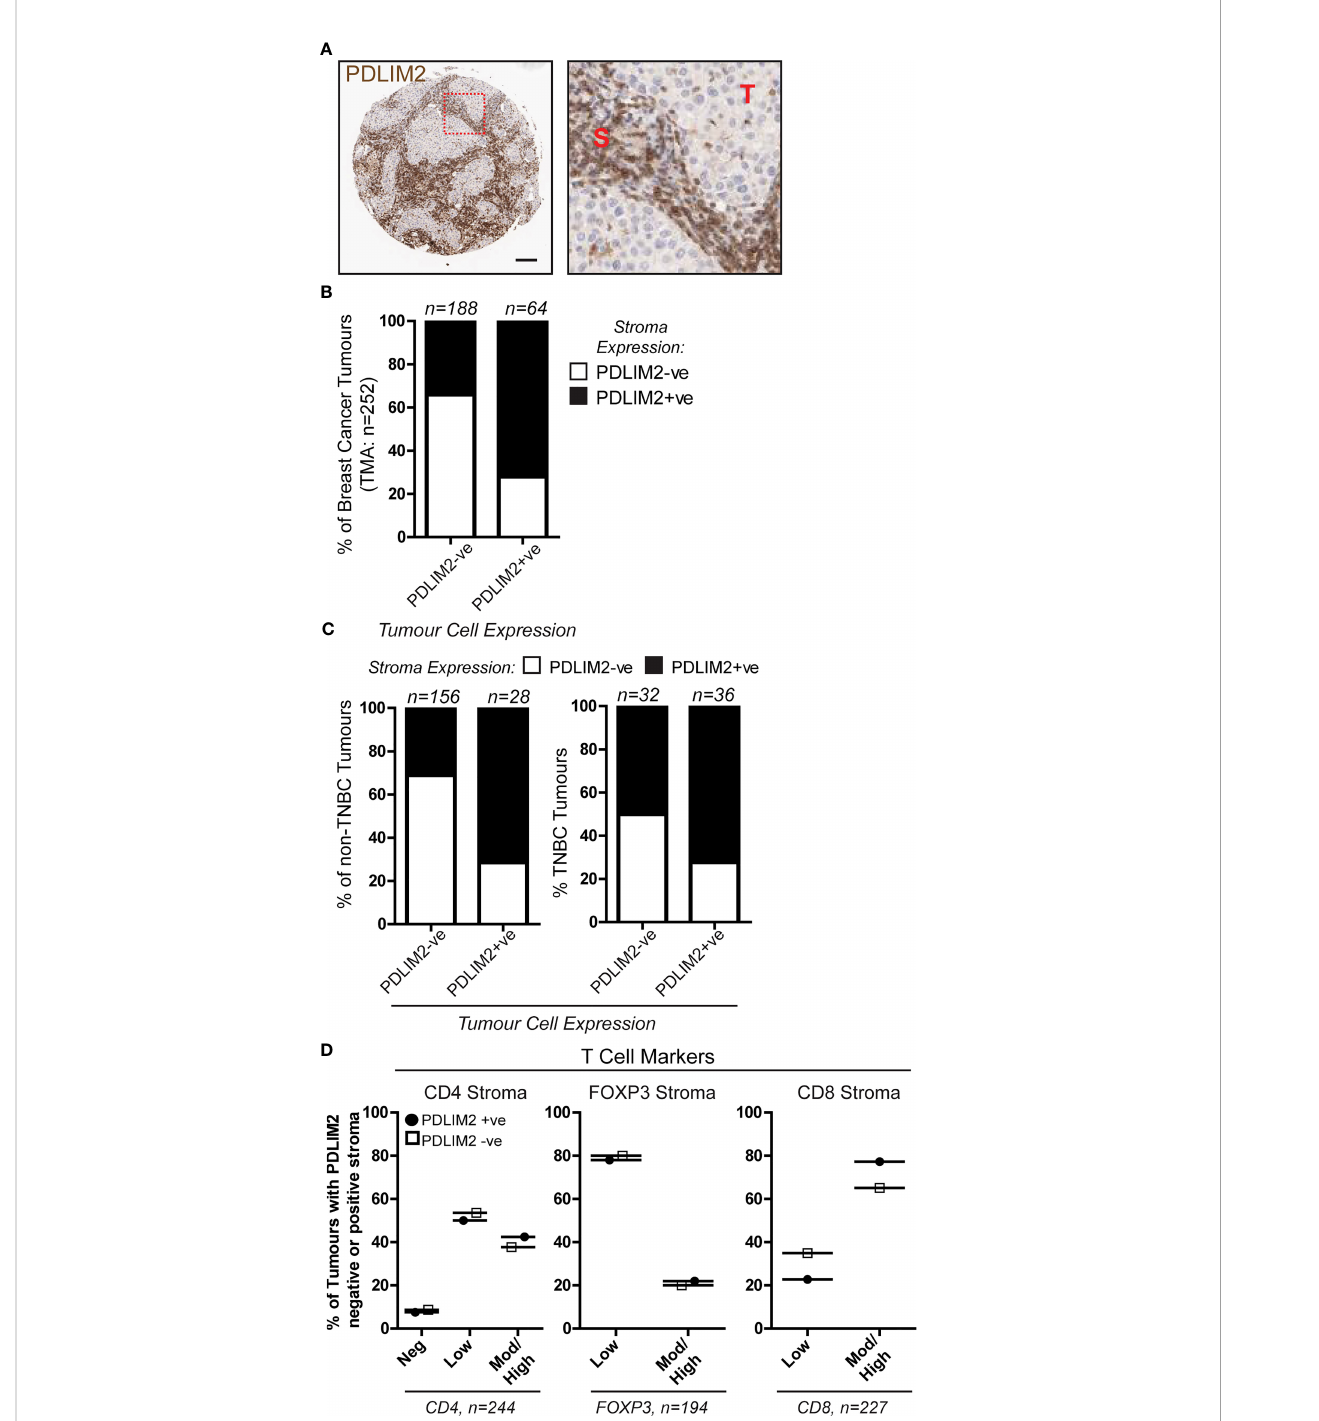
FIGURE 1 PDLIM2 expression in PDLIM2-negative and -positive breast cancer tumour-in fi ltrating stroma is not associated with any particular T cell population. A Breast Cancer TMA from a cohort of approximately 250 samples from the Northern Ireland Biobank (NIB) was stained for PDLIM2 protein expression by immunohistochemistry (11). (A) : Representative micrographs of PDLIM2 IHC staining in breast tumour (Her2-enriched). Right panel shows zoomed area to illustrate PDLIM2 staining in tumor cells (T) and stromal cells (S). Scalebar represents 100µm. (B, C) : Quanti fi cation of PDLIM2 negative (-ve) or positive (+ve) expression in stroma of all breast cancer cores (B) , or data shown separately for non- TNBC (left panels) and TNBC tumours (right panels) across the cohort (C, D) : Expression of T cell markers scored as negative, low, moderate (mod) or high in PDLIM2-ve or +ve stroma. Data are presented as percentage of each marker expression score within PDLIM2 -ve or +ve